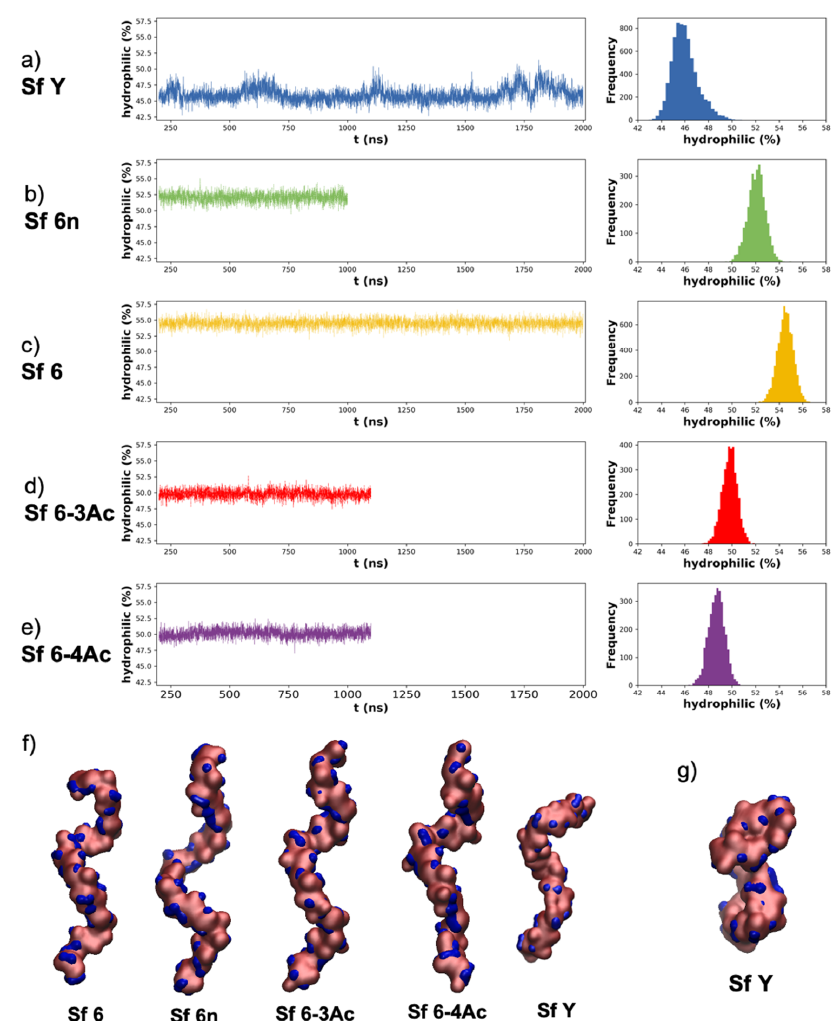
Figure 4. Time series and histogram plots of relative % hydrophilic surface area for O-Ags: ( a ) Sf Y, ( b ) Sf 6n, ( c ) Sf 6, ( d ) Sf 6-3Ac, ( e ) Sf 6-4Ac. VMD Quicksurf representation of the hydrophilic (blue) and combined neutral/hydrophobic (pink) surfaces of the O-antigens are shown in ( f ) ordered from highest (Sf 6) to lowest (Sf Y) % hydrophilic surface. ( g ) VMD Quicksurf representation of a collapsed Sf Y conformation from around. Note that for Sf Y and Sf 6, longer simulation times were required to reach convergence (both 2000 ns) than for Sf 6n (1000 ns), Sf 6-3Ac (1100 ns), and Sf 6-4Ac (1100 ns).